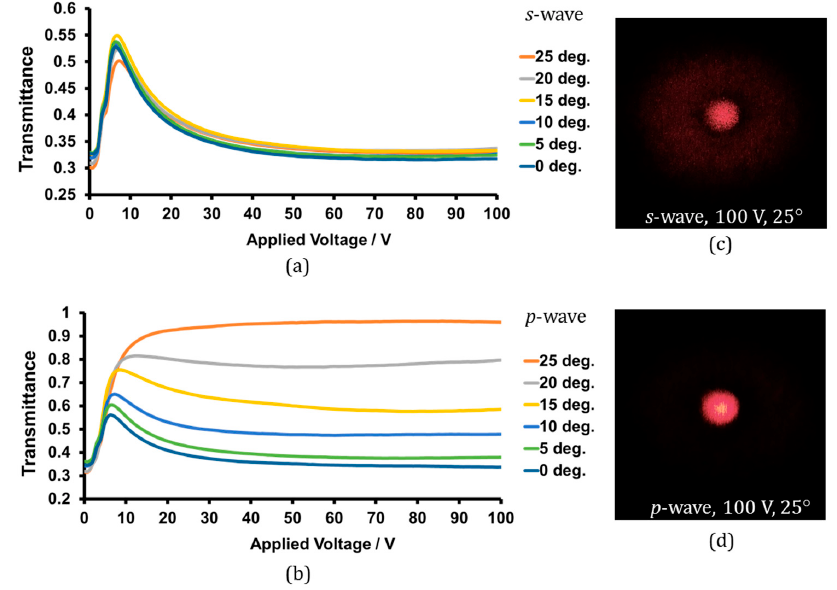
Figure 7. T-V curves of the PDLC film with large droplets probed by the ( a ) s -wave and ( b ) p -wave at different incident angles of 0 °− 25 ° . ( c , d ) are the transmitted patterns at an incident angle of 25 ° for s -wave and p -wave at 100 V, respectively.